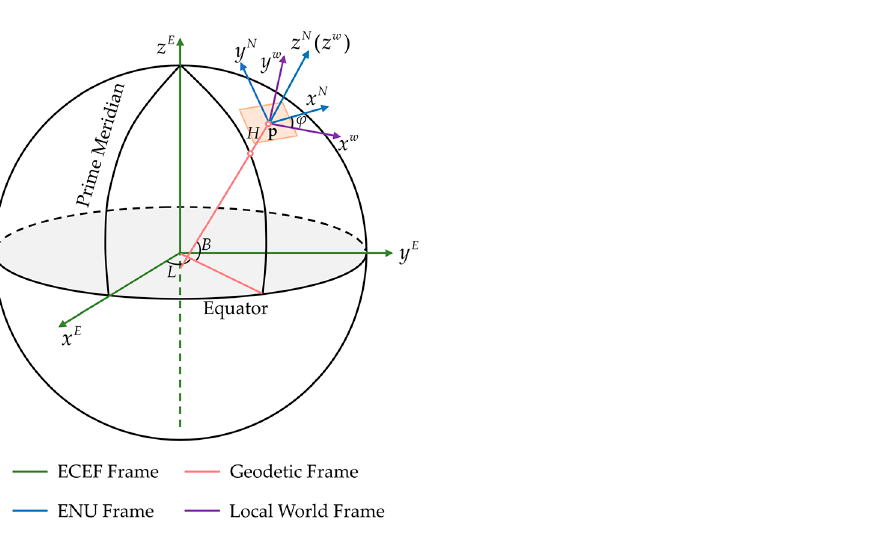
Figure 1. An illustration of the ECEF, Geodetic, ENU, and local world frames. In this paper, R w and p w represent the rotation and translation of the body frame with respect to the local world frame, and q w is the corresponding quaternion form of the rotation R w . v w , b a , and b g denote the velocity of the origin of the body frame measured in the local world frame, accelerometer bias, and gyroscope bias, respectively. p b stand for the extrinsic parameters between the camera and IMU. δ t r and δ receiver clock error and receiver clock drifting rate, respectively. ϕ is the yaw between the local world frame and the ENU frame. R N is the rotation matrix of the local world frame with respect to the ENU frame. p E denotes the translation of the ENU frame with respect to the ECEF frame. p b is the extrinsic translation parameter between the GNSS receiver and IMU. [ · ] × represents the skew-symmetric matrix of a 3D